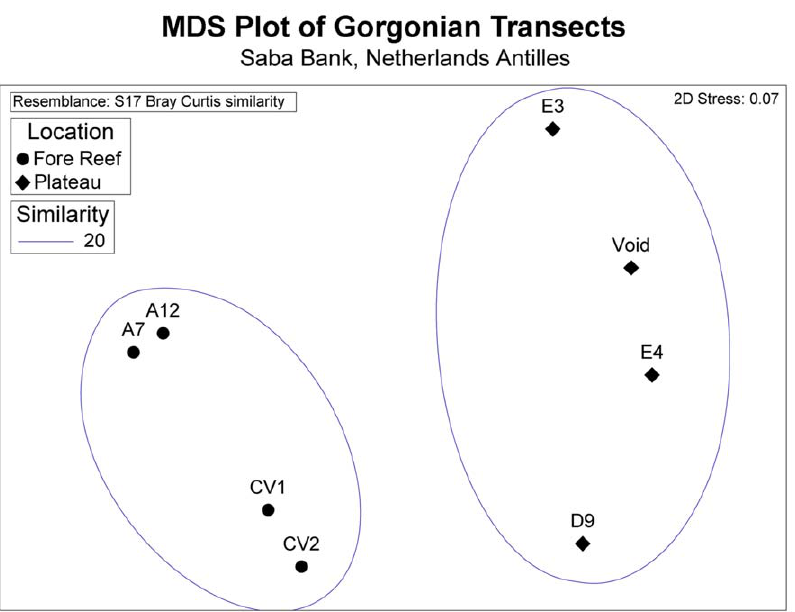
Figure 7. Ordination plot of Saba Bank transects. A non-metric multidimensional scaling (MDS) plot based on Bray-Curtis dissimilarity measures derived from species abundance values in 8 quantitative transects. Fore-reef sites (A, CV) are significantly different (ANOSIM, P , 0.05) from plateau sites (D, E, and Void), but not significantly different from each other. There is good separation between fore-reef and plateau sites, with slight prospect of a misleading representation (2D stress , 0.10).